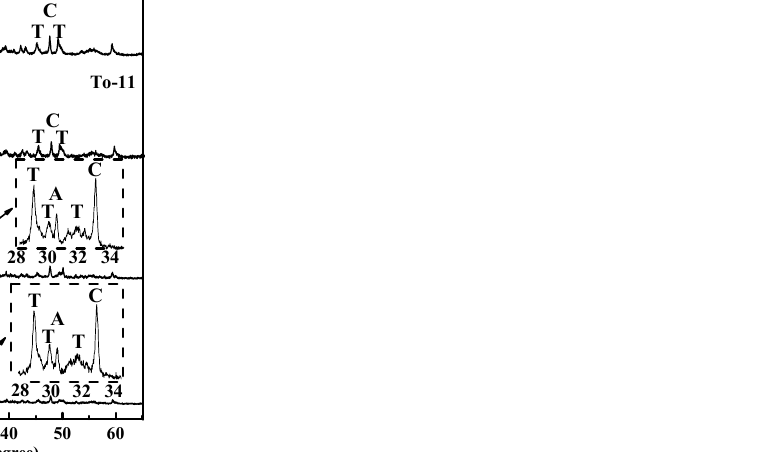
Figure 4. XRD patterns of products synthesized at different Ca/Si molar ratio at 200 °C for 12 h. T— 11Å-TA; C—Ca 3 Al 2 O 6 ; A—Analcime; Q—Quartz.